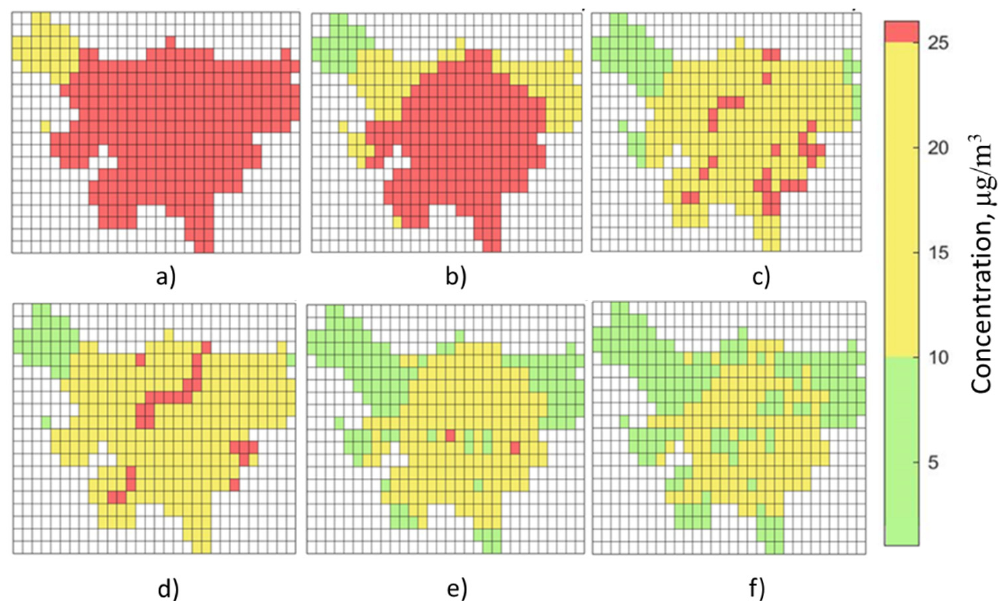
Figure 16. PM2.5 monthly average measured by the ROM network in Milan: ( a ) January 2020; ( b ) February 2020; ( c )